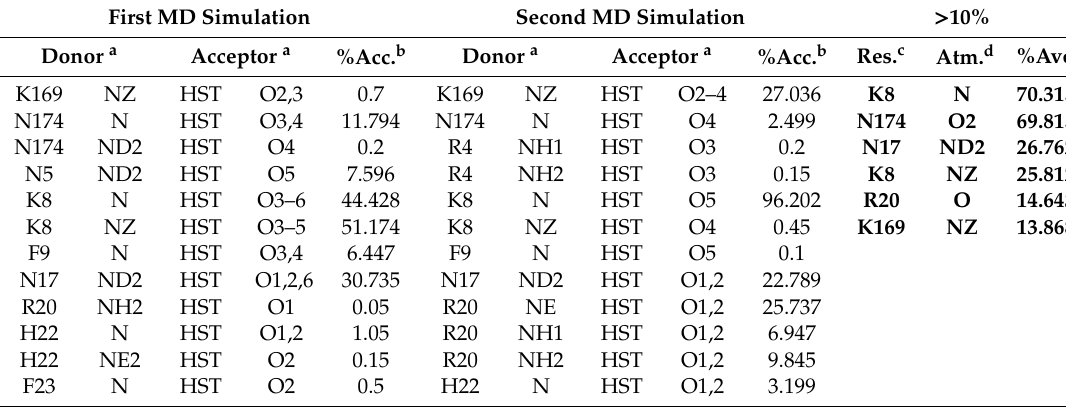
Table 3. The accumulated percentage occupancies (%Acc.) of hydrogen bonds formed between M 2-1 and HST during 20 ns MD trajectory were obtained for the simulation duplicates. The amino acid residues of the protein involved in hydrogen bonds with average values (%Ave.) of accumulated percentage occupancy higher than 10% (highlighted in bold) were considered as a significant non-covalent interaction for the molecular stabilization of the M 2-1 / HST